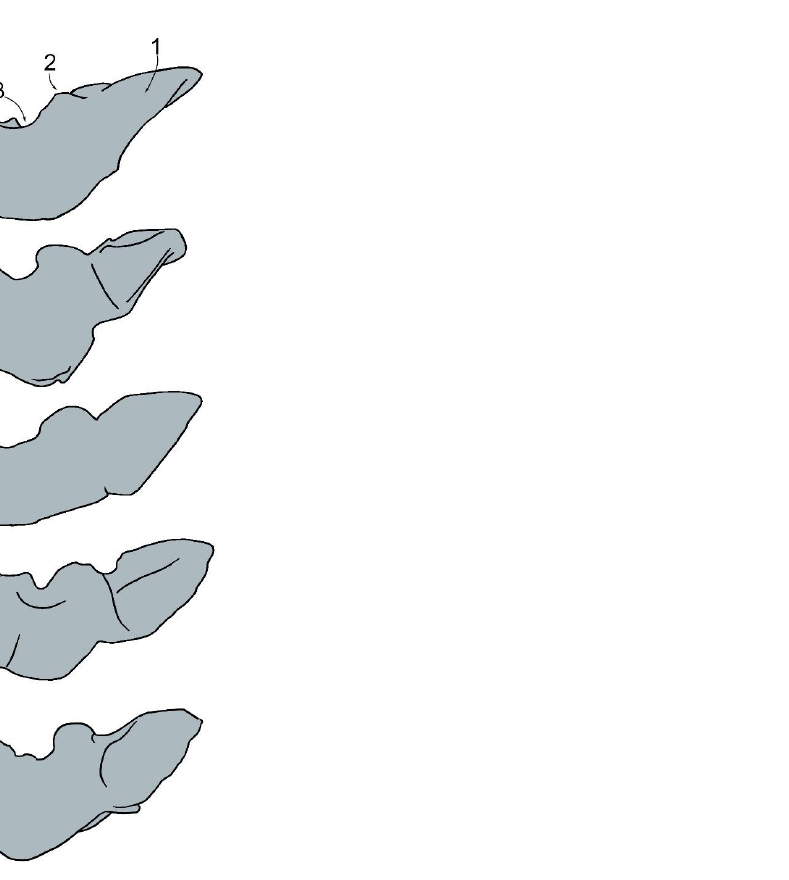
Figure 16. Schematic representation of posterior portions of eurhinodelphinid skulls in dorsal view. Not to scale. ( A ) Iniopsis caucasica . ( B ) Eurhinodelphis bossi . ( C ) Eurhinodelphis cocheteuxi . ( D ) Eurhinodelphis longirostris . ( E ) Schizodelphis morckhoviensis . ( F ) Vanbreenia trigonia . ( G ) Mycteriacetus bellunensis . ( H ) Schizodelphis sulcatus . ( I ) Xiphiacetus cristatus . ( J ) Ziphiodelphis abeli . ( K ) Ziphiodelphis sigmoideus. ( L ) MGPT-PU 13881/1, Ziphiodelphis sigmoideus.